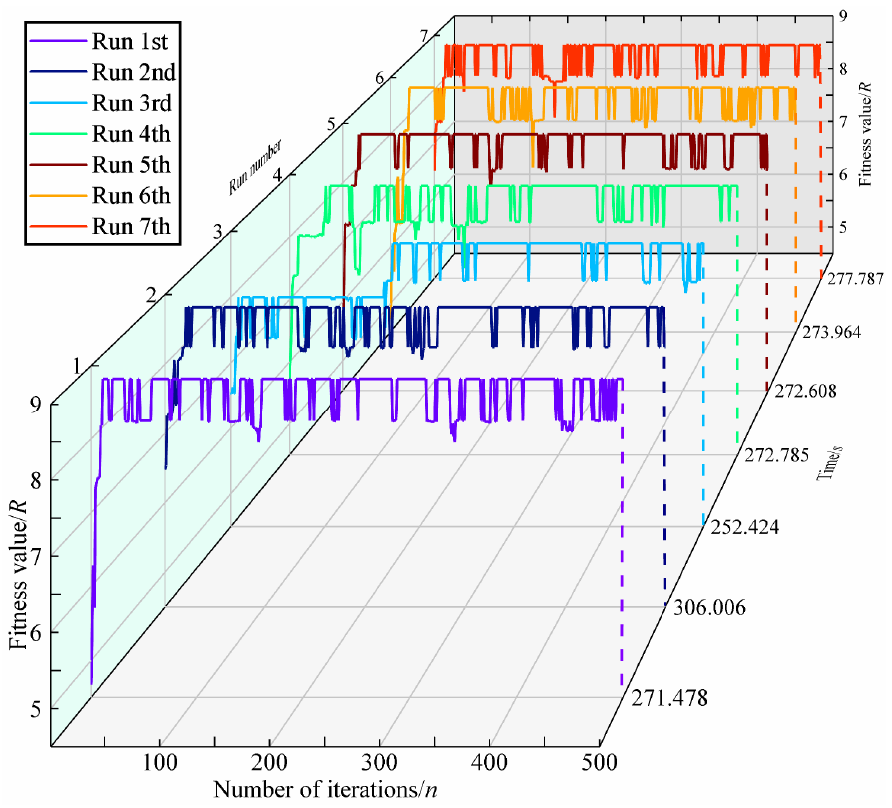
Figure 10. The curve of traditional genetic algorithm number of iterations N-strength ratio, R. Table 5. Calculation results of traditional genetic algorithm.